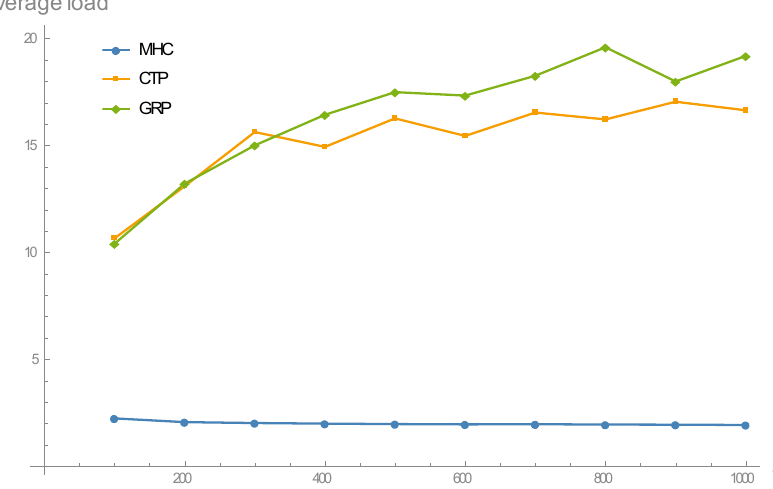
Figure 6. Evolution of the average traffic load with regard to the network size, for the routing metrics considered in the analysis. The surprisingly small value obtained for MHC is a consequence of the large network densities managed in the simulation.